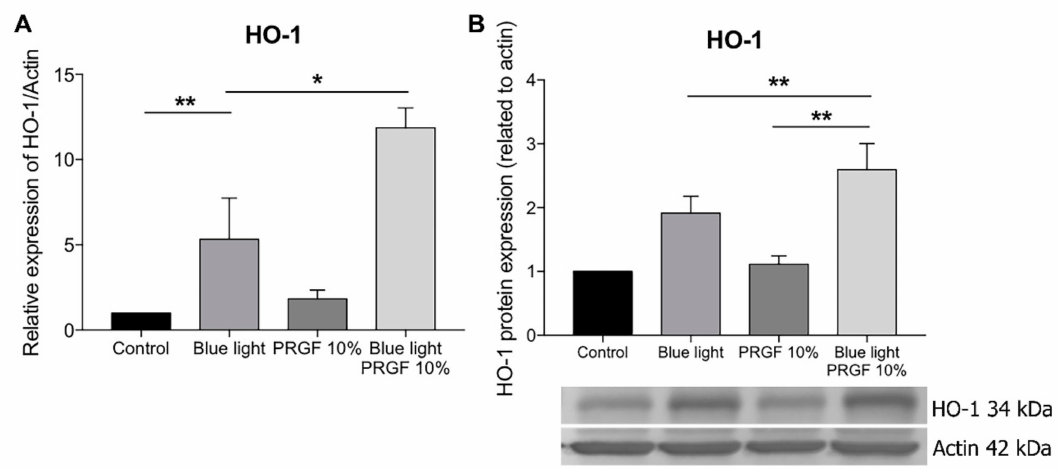
Figure 7. ARPE19 cell cultures. ( A ) HO-1 gene expression related to actin, blue light stimulated the expression of HO-1 as compared with the control, PRGF combined with blue light treatment showed a higher expression of HO-1 as compared with the other groups; ( B ) HO-1 protein expression related to actin, blue light increased the expression of HO-1 as did PRGF combined with blue light treatment.